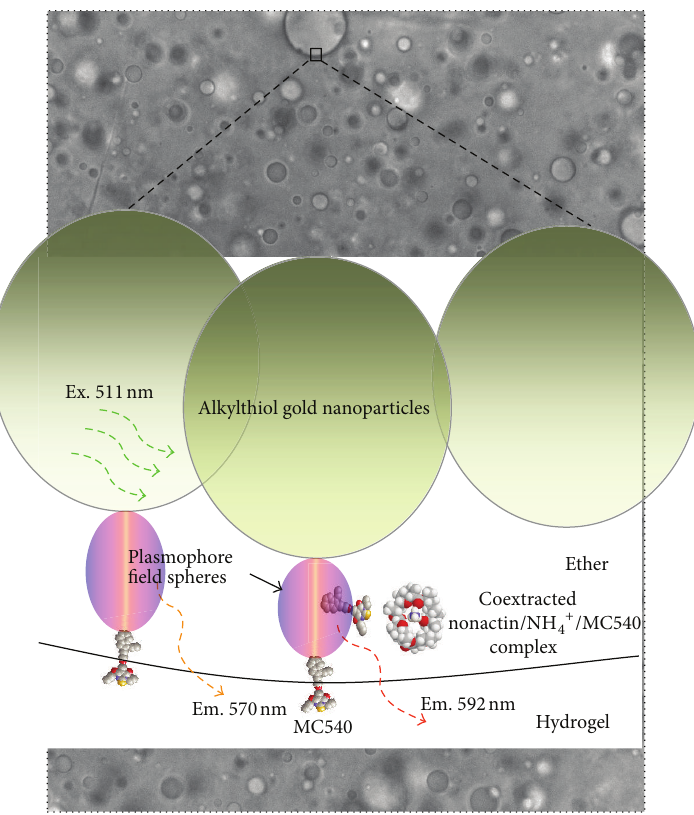
Figure 1: A small surface subsection of an emulsion droplet is viewed (the background is a microscopy image of the hydrogel/ether emulsion). One dye molecule has been coextracted into an imagined plasmophore field sphere acting as an effective FRET acceptor.